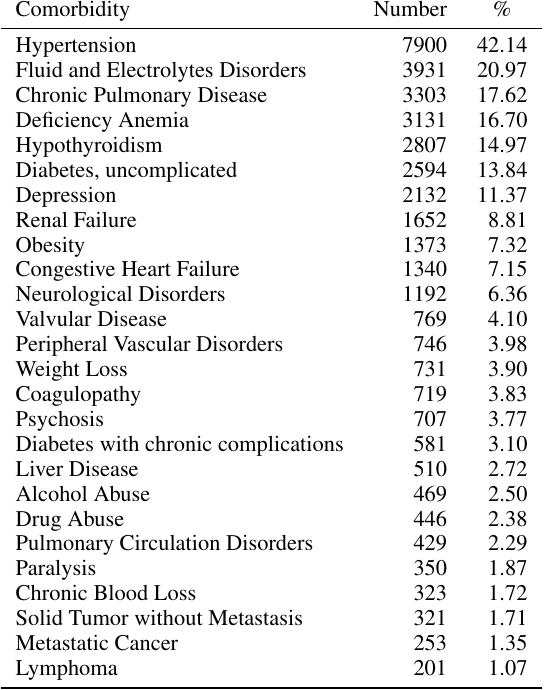
Table 2: Frequencies of comorbidities in patients with SS.